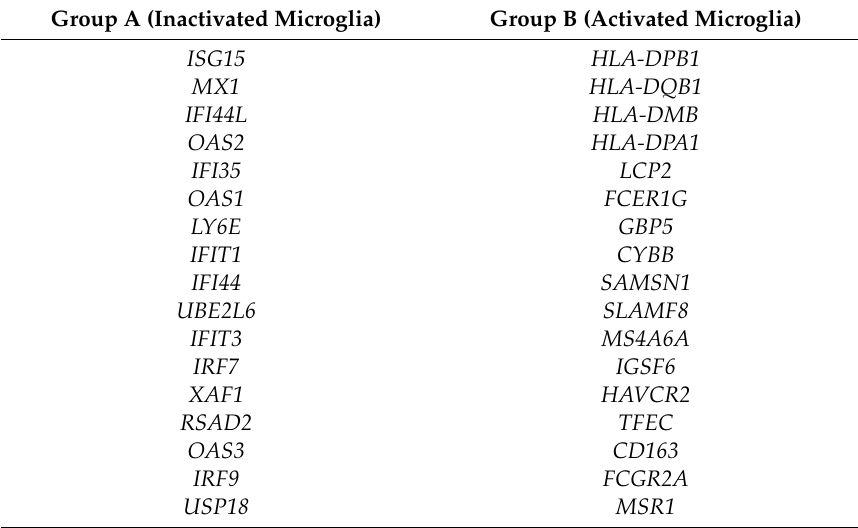
Table 5. Microglial deconvolution. BST2 (CD317) was used to identify the co-expressed genes associated with inactivated microglia (group A), while for activated microglia TREM2 , HLA-DRA , ENTPD1 , CD80